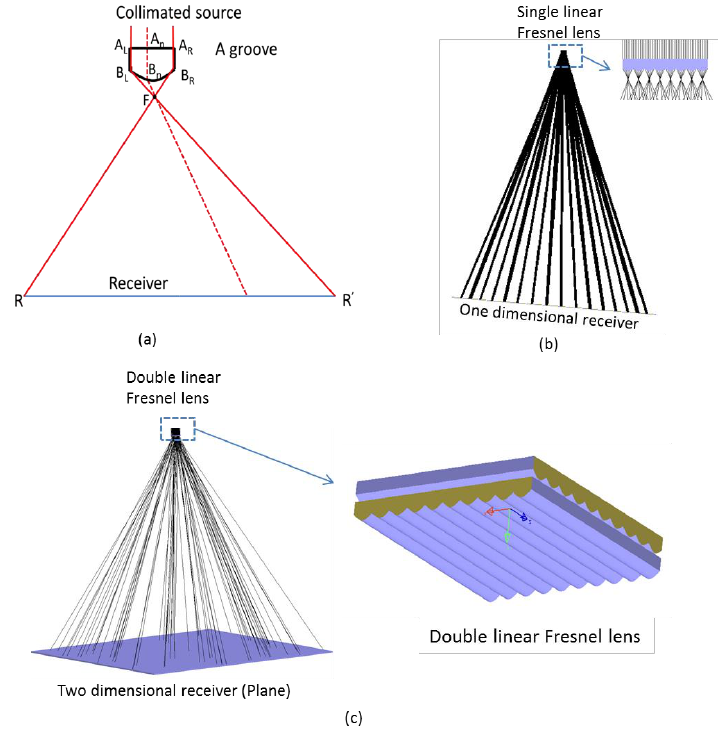
Figure 6. ( a )Design method for a segment of a linear Fresnel lens. ( b ) A single linear Fresnel lens redistributes light to a 1D receiver; ( c ) A light distributor including two linear Fresnel lenses can redistributes light to a 1D receiver. ( c ) A light distributor including two linear Fresnel lenses can redistribute the light uniformly over a redistribute the light uniformly over a plane.